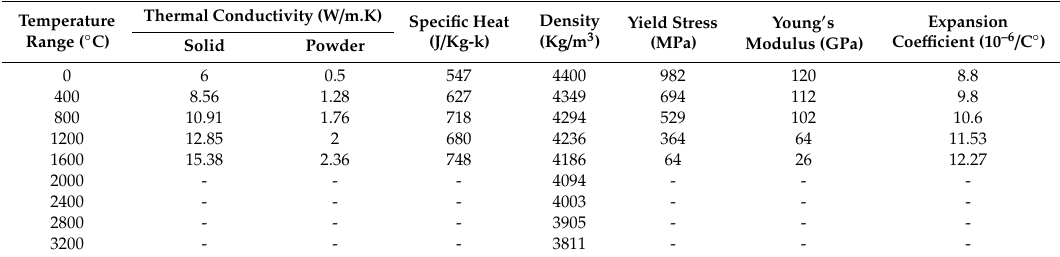
Table 2. Temperature dependent material properties of Ti-6Al-4V.